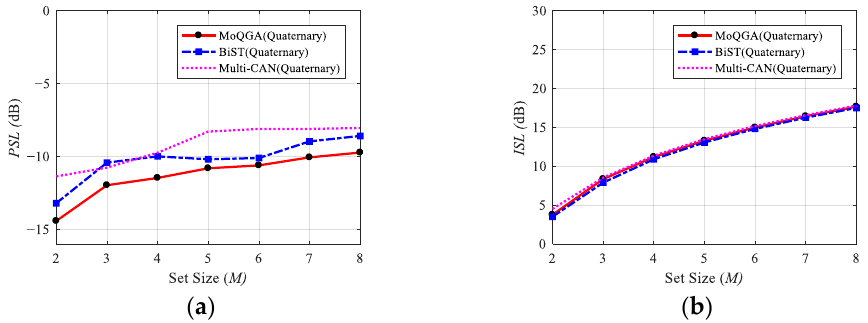
Figure 13. PSL and ISL values of MIMO radar quaternary phase code sequence set obtained by MoQGA and other methods under different sequence set size and N = 32. ( a ) PSL ; ( b ) ISL .